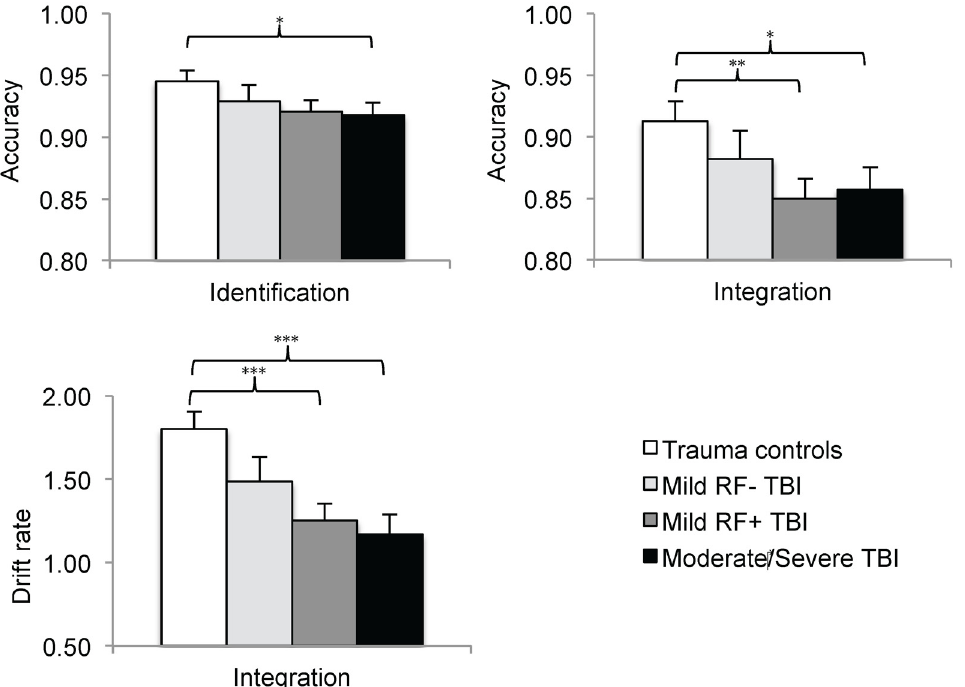
Fig 2. Analyses differentiating TBI severity on visual identification accuracy, visual integration accuracy and visual integration drift rate . Note . * P < .05 ** P < .01 *** P <